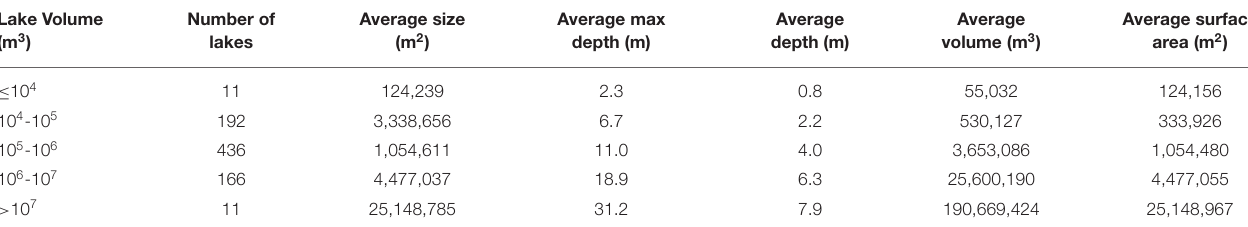
TABLE 1 | Averages of morphology traits from 816 surveyed lakes provided by Minnesota Department of Natural Resources (DNR).